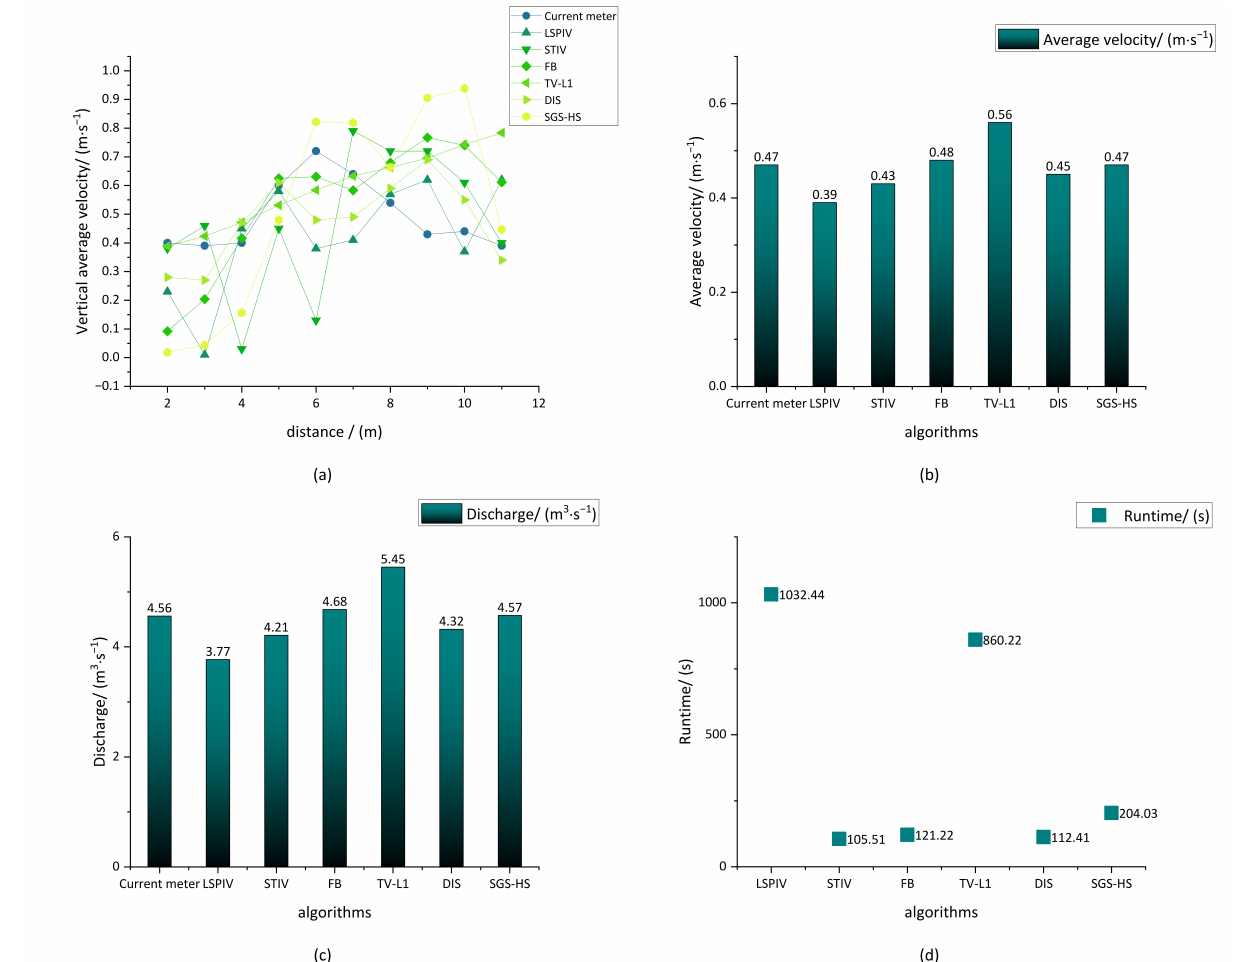
Figure 6. Comparison of experimental results: ( a ) vertical average velocity; ( b ) average velocity; ( c ) discharge; ( d ) time